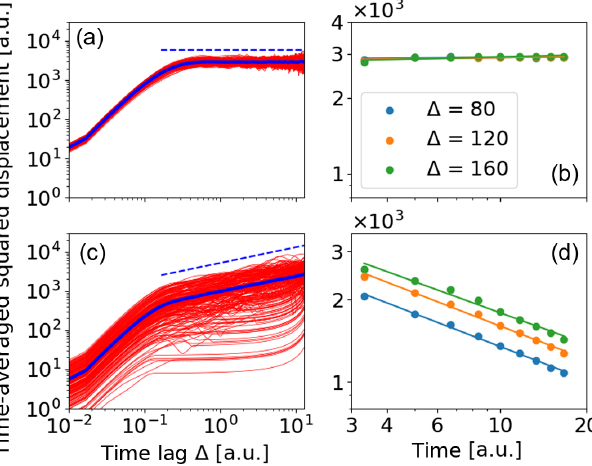
FIG. 3. CTRW simulations. (a,b) Exponentially distributed WTs (a simple RW with τ 0 ¼ 10 s ). (c,d) Power-law WTs, Eq. (2), with α ¼ 0 . 6 . In panels (a) and (c), each of the red lines is the TASD calculated for a single simulation versus the time lag Δ , and the blue line is the average TASD, Eq. (3), over an ensemble of 200 simulations. The blue dashed lines are the theoretical scaling. In panels (b) and (d), we plot the averaged TASD, Eq. (3), versus the total time of the simulation. Simu- lations were done in a bounded domain of 100 × 100 .